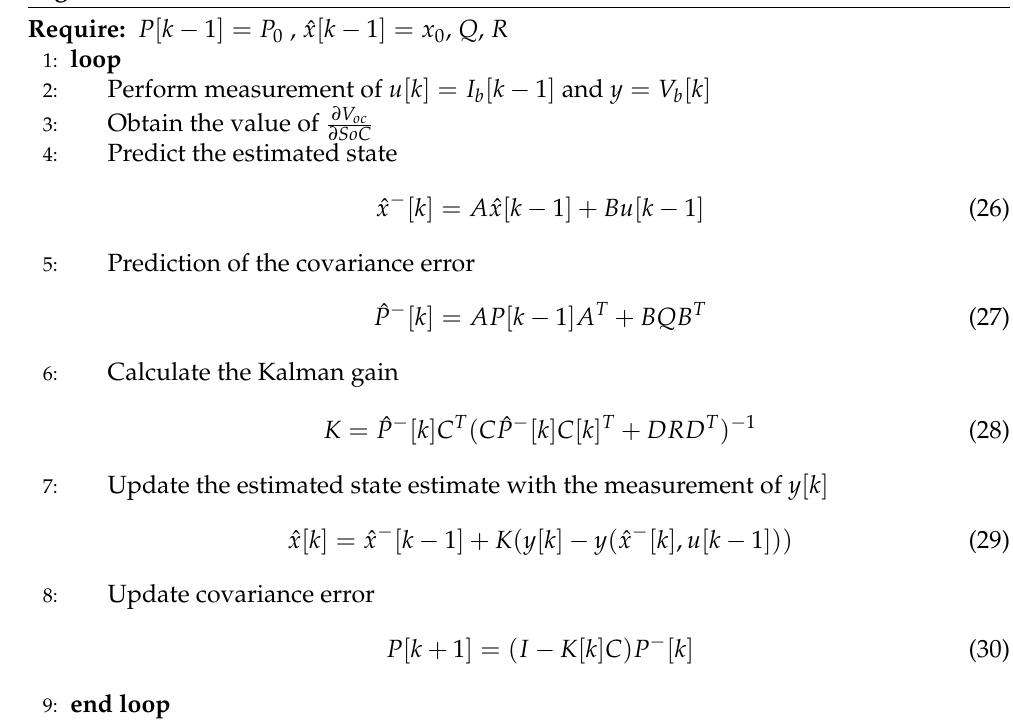
Algorithm 1 Estimation of the SoC .